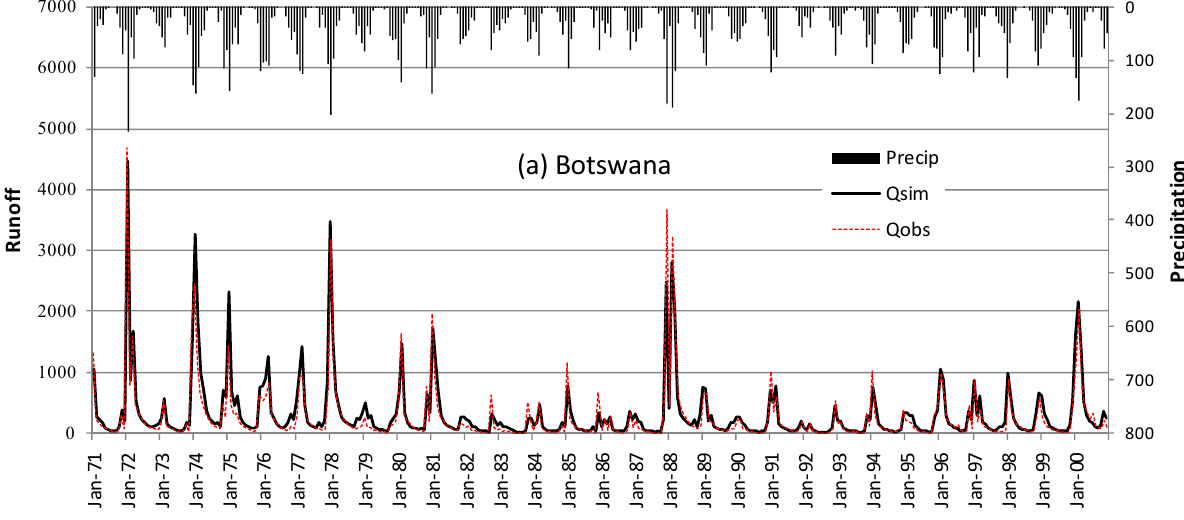
Figure 4. Runoff calibration and validation for the Limpopo River